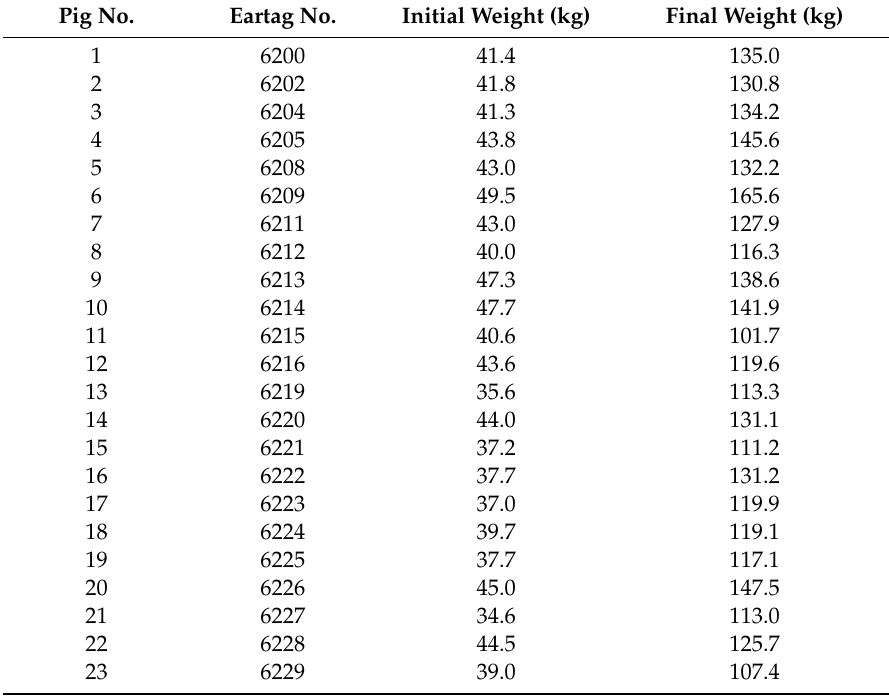
Table 1. Animal identification number, initial and final weight of each animal monitored. Pig No. Eartag No.